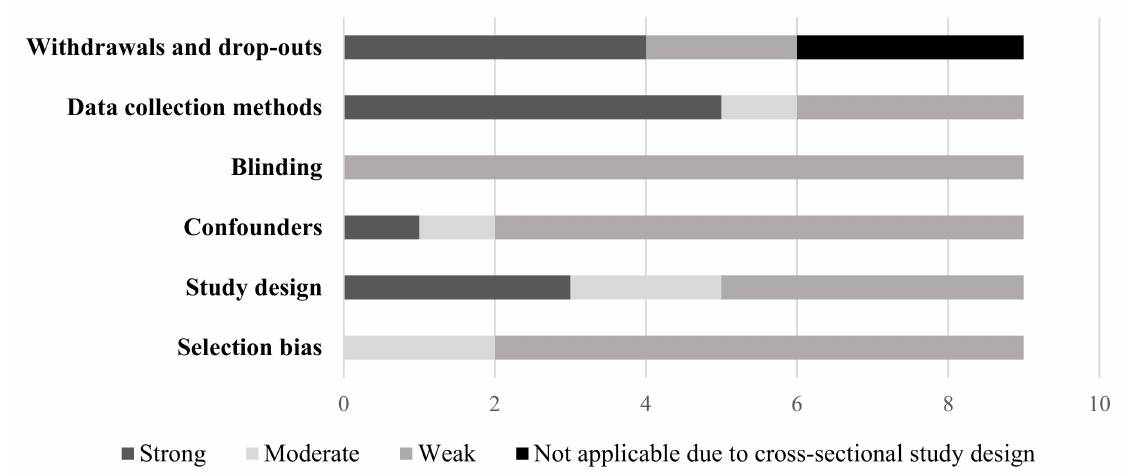
Figure 4. Quality of quantitative studies by assessment item—Nature